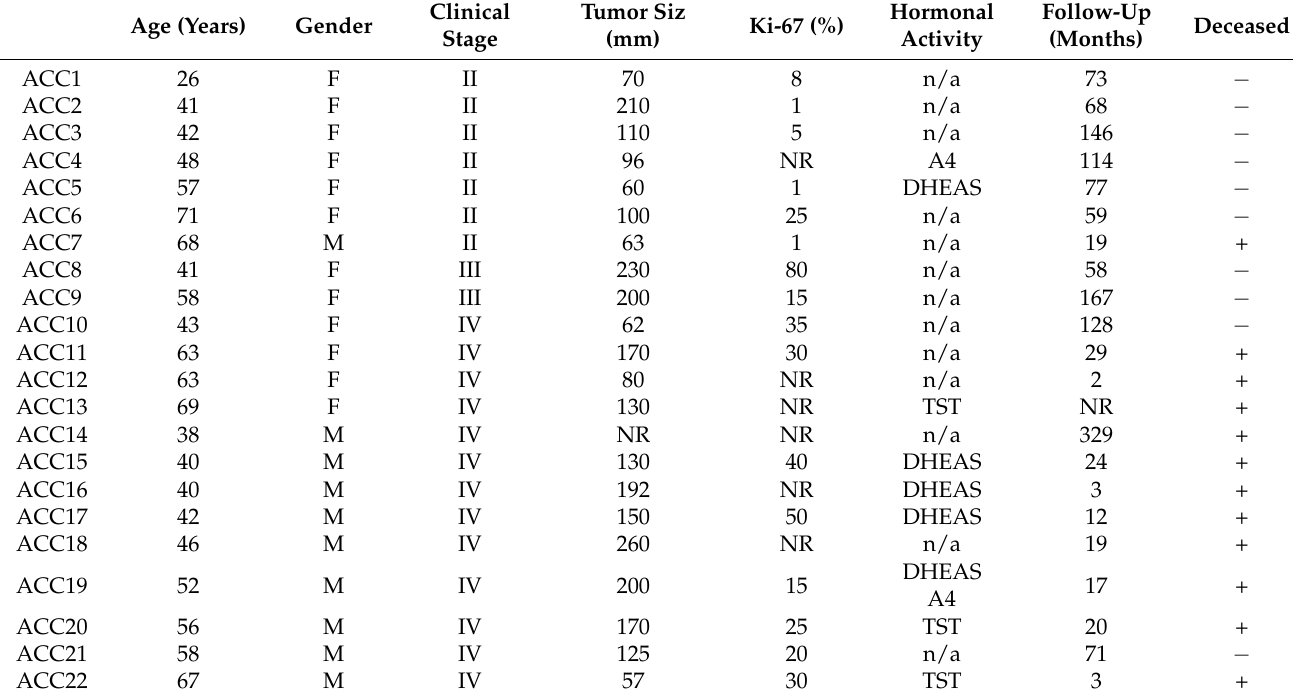
Table 2. Detailed clinical characteristics of patients with adrenocortical